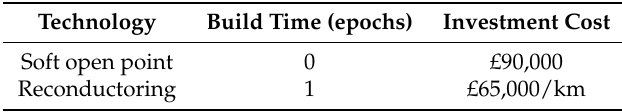
Table A1. The available technologies for investment.